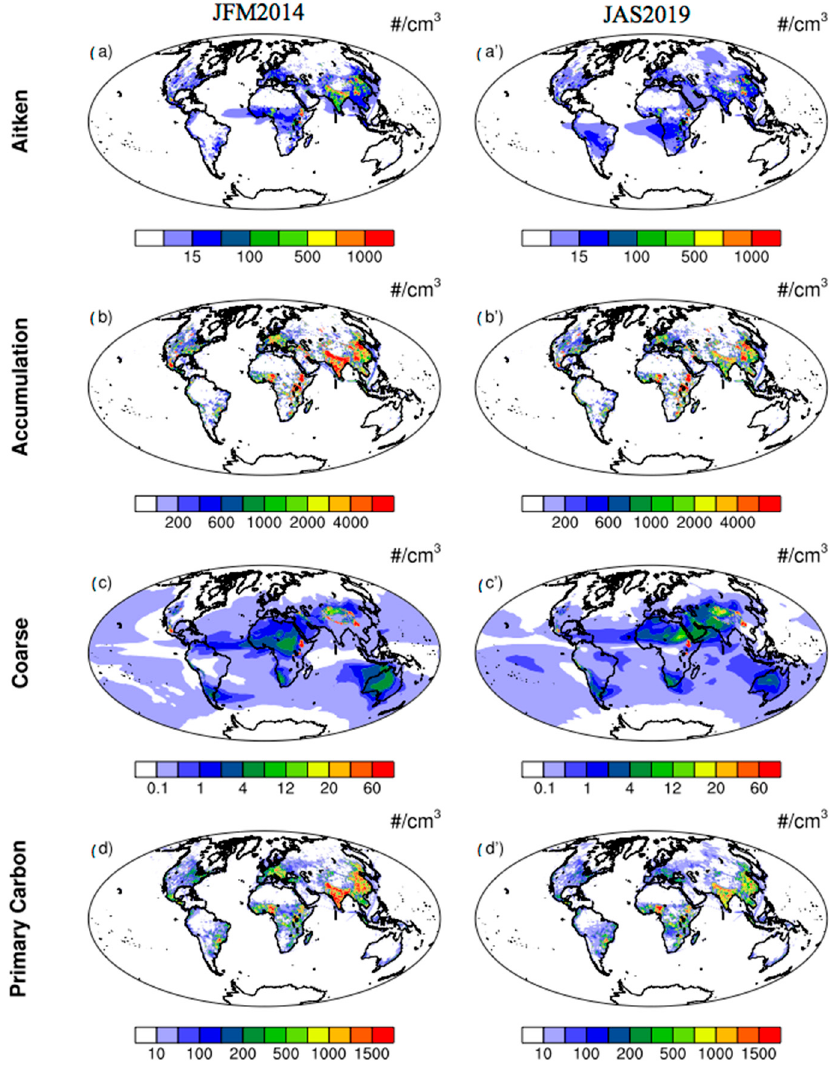
Figure 3. Number concentrations (per m 3 ) for the Aitken, accumulation, coarse, and primary carbon mode averaged for the periods ( a – d ; left) JFM2014 and ( a’ – d’ ; right) JAS2019 in BAM AMIC experiments.